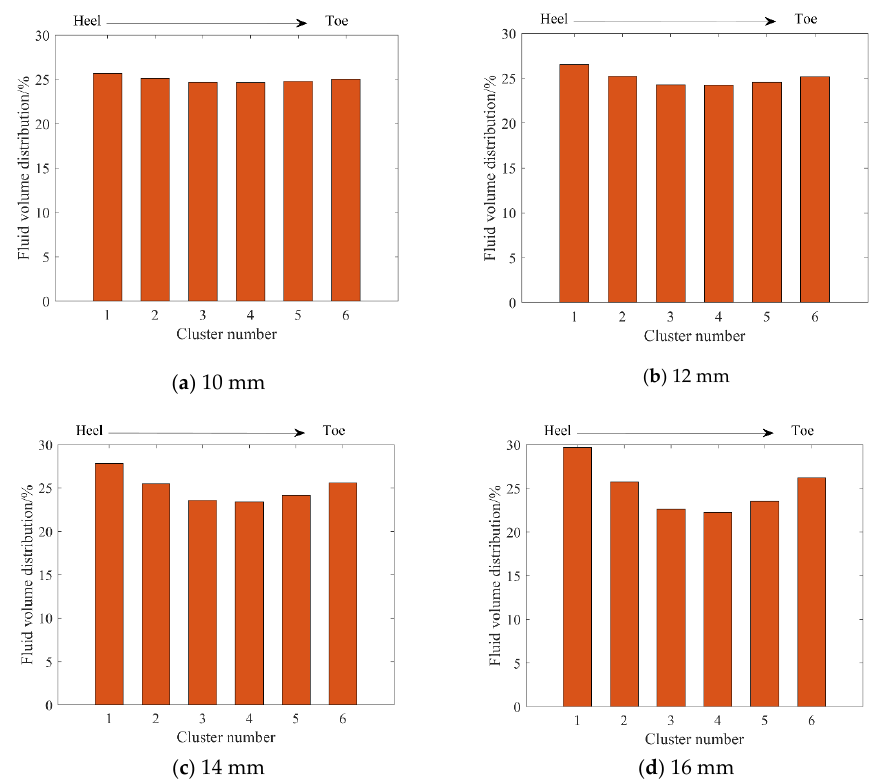
Figure 10. Fluid allocations at different perforation diameters.